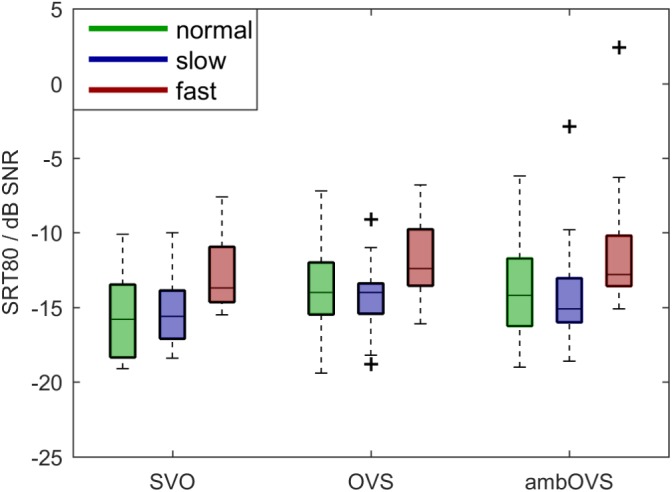
Boxplots of participants’ SRT80s for normal (green), slow (blue), and fast (red) speech rates and SVO, OVS, and ambOVS sentence structures. Repeated measures ANOVA revealed a main effect of linguistic complexity with significant lower SRT80s for SVO sentences compared to OVS and ambOVS sentences and an effect of speech rate with higher SRT80s for fast speech compared to normal and slow speech.